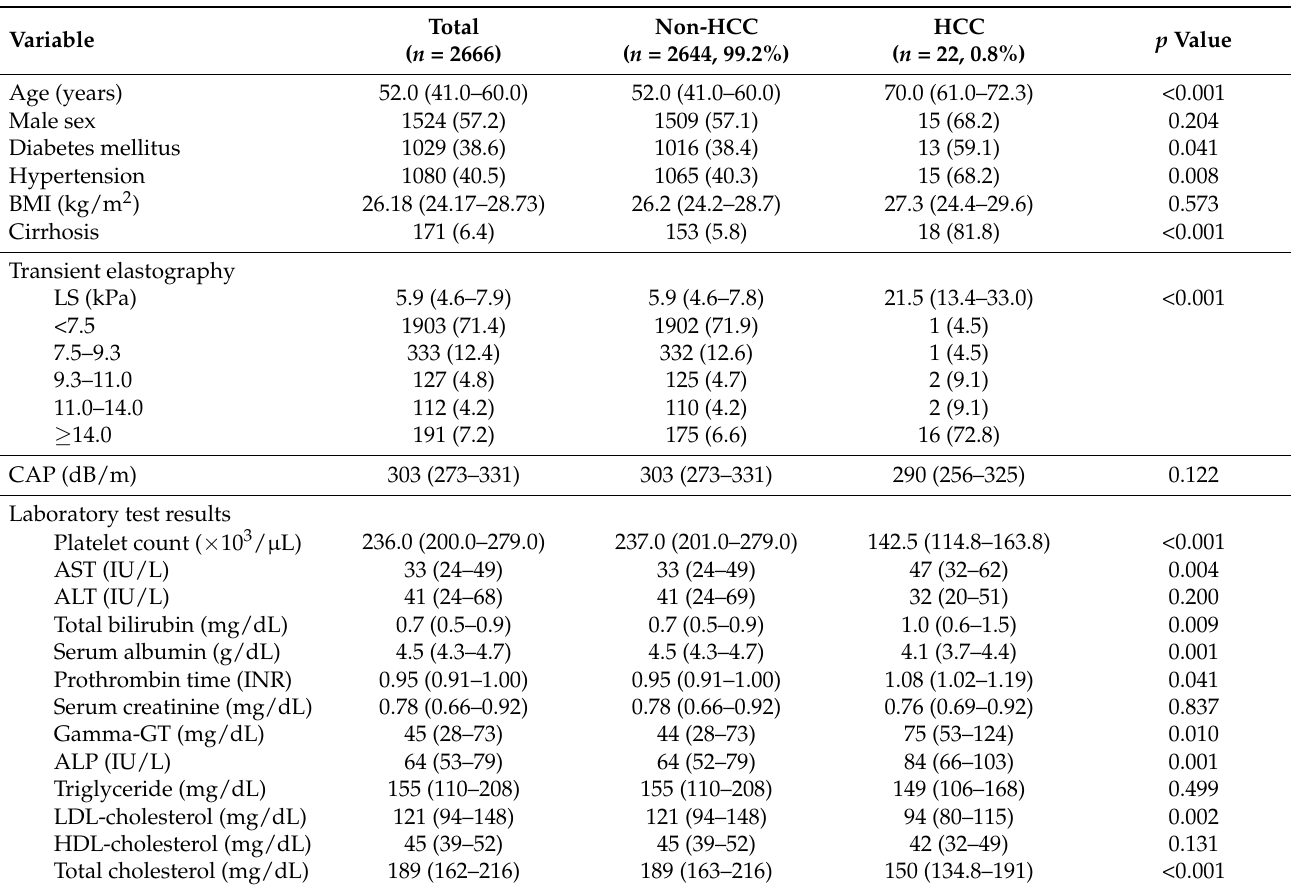
Table 1. Baseline characteristics in the training